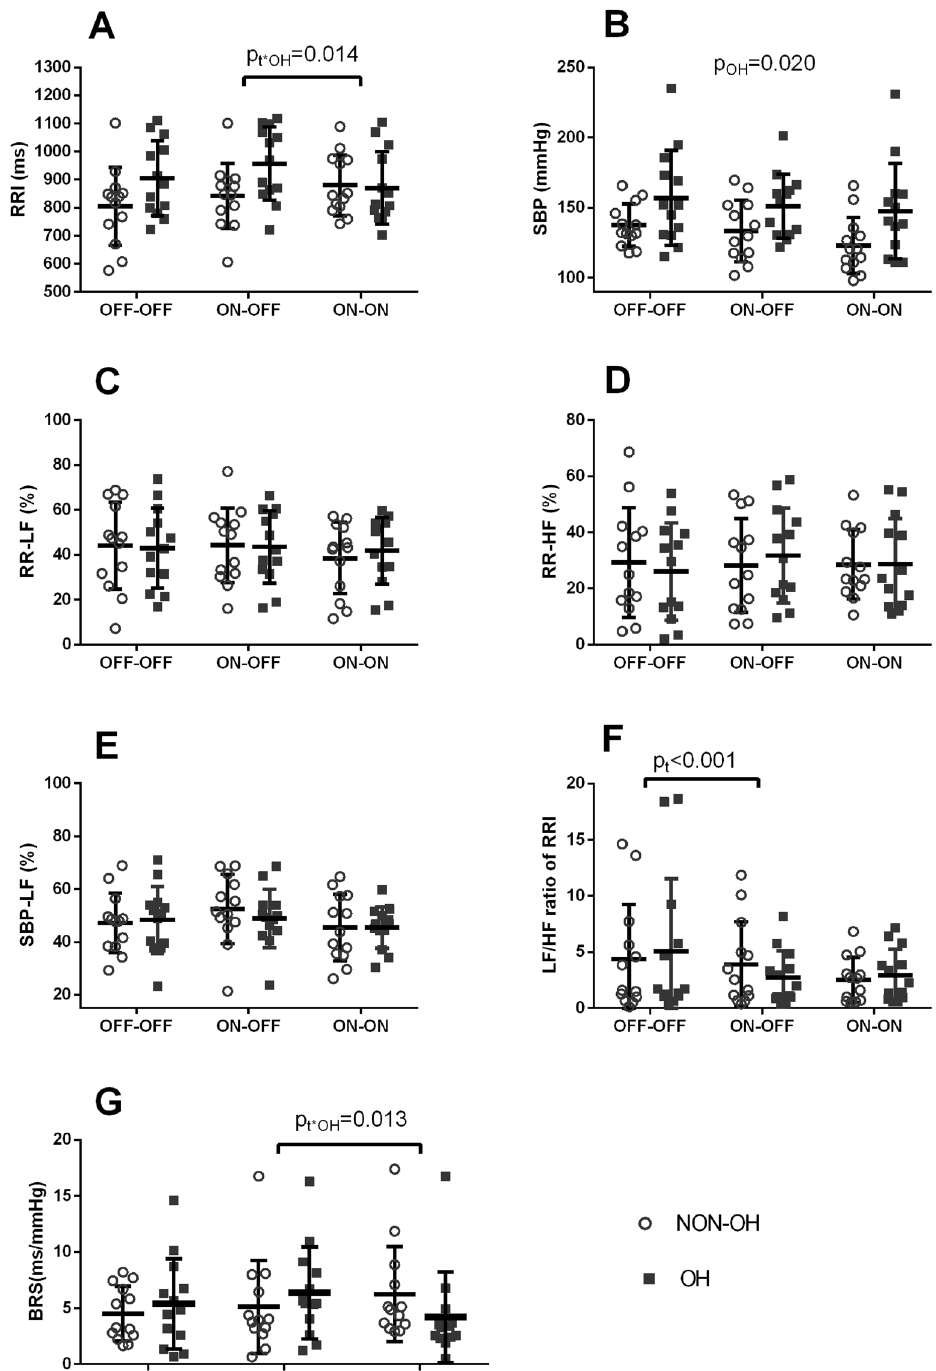
Figure 1. Cardiovascular autonomic function parameters at rest. p t is for repeated measures, p OH for the effect of OH, and p t is for an interaction between repeated measures and OH. BRS = baroreflex sensitivity, * OH HF = high frequency, LF = low frequency, OH = orthostatic hypotension, RRI = RR interval, SBP = systolic blood pressure; OFF-OFF = both off STN-DBS and off dopaminergic medication, ON-OFF = on STN-DBS and off dopaminergic medication, ON-ON = both on STN-DBS and on levodopa. Data are presented as the mean ± SD, and analyzed by repeated measures